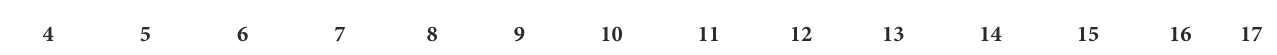
TABLE 1 Bivariate correlations between observed